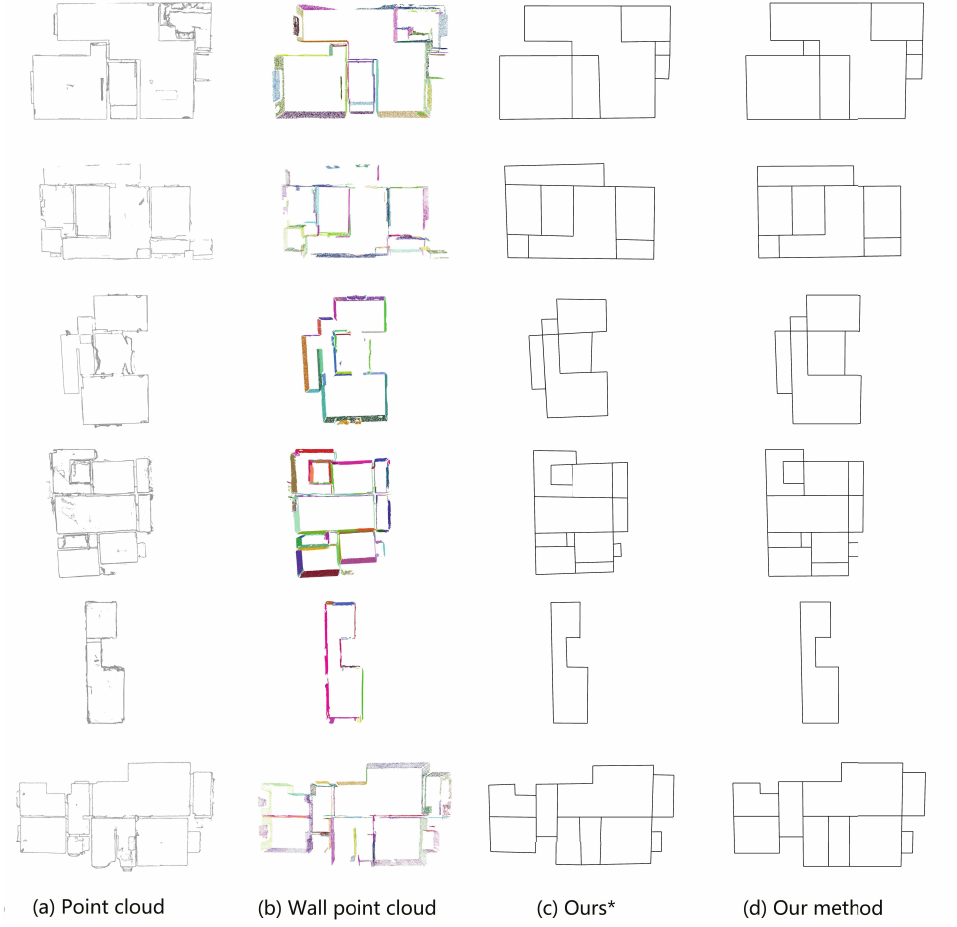
Figure 9. Examples of floorplans predicted by our method on our datasets. From left to right, we display the density map of the point cloud, the wall point cloud, our*, and the result of our method, respectively. Our* is the non-Manhattan result of our